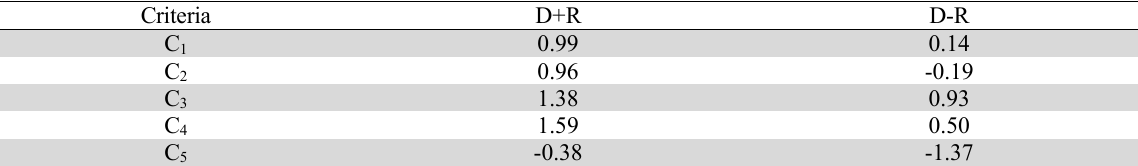
Casual relationships between criteria